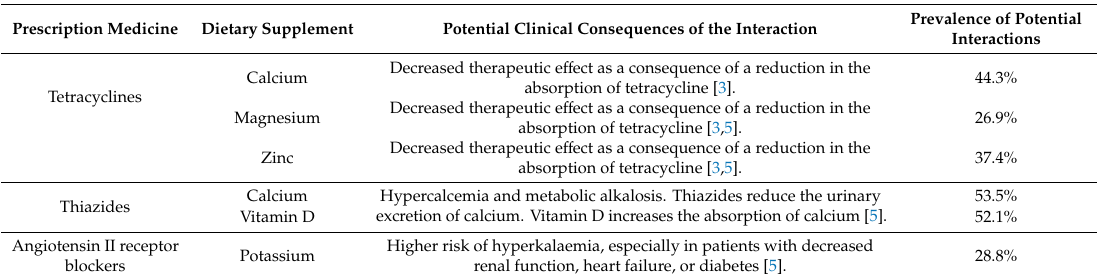
Table 1. Drug–dietary supplement interactions and their